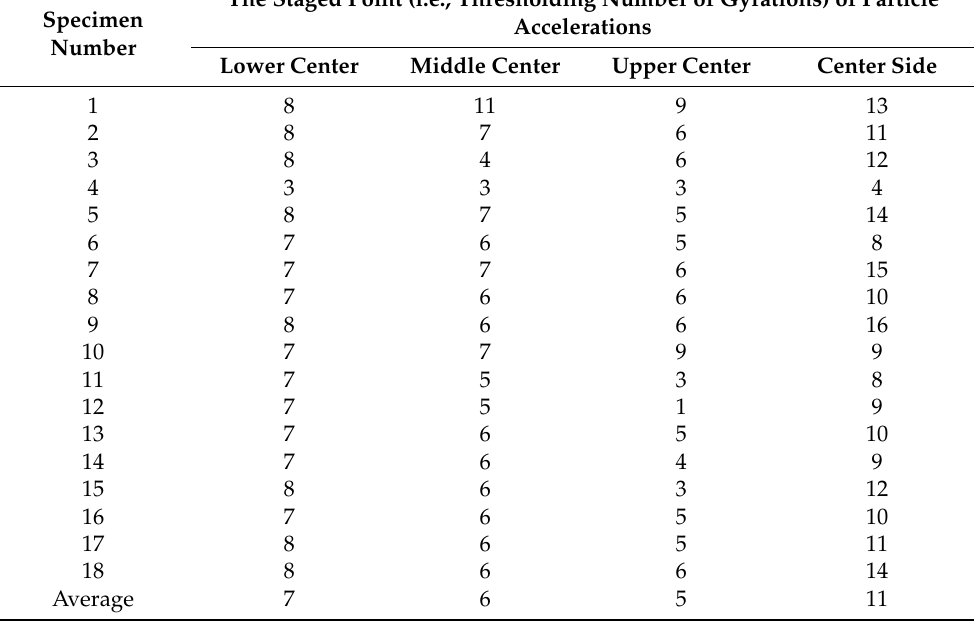
Table 4. The staged point of particle accelerations at four different positions of eighteen specimens. The Staged Point (i.e., Thresholding Number of Gyrations) of Specimen Number